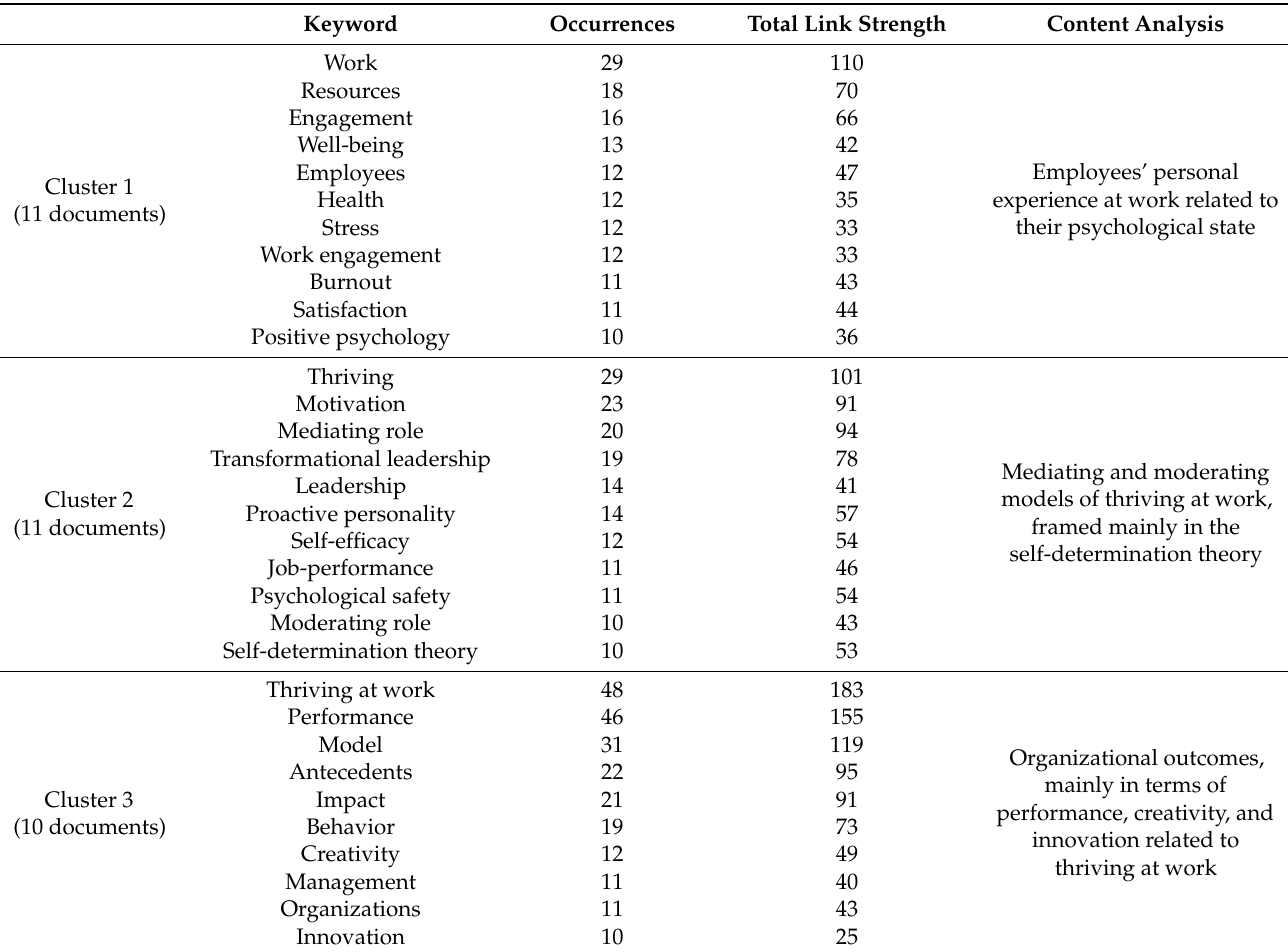
Table 12. Content analysis of the three resultant clusters of most popular keywords in the topic of thriving at